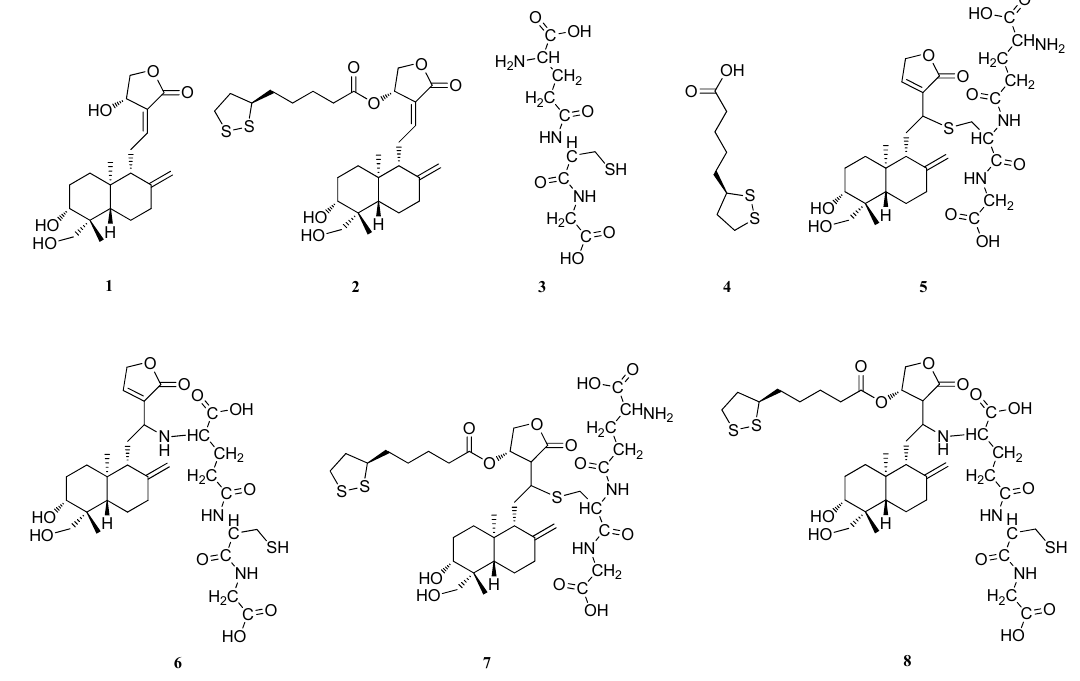
Figure 1. Structures of compounds 1–7 . Andro ( 1 ), AL-1 ( 2 ), GSH ( 3 ), LA ( 4 ), 14-deoxy- 12-(glutathione-S-yl)-andrographolide ( 5 ), 14-deoxy-12-(glutathione-amino)-andrographo-